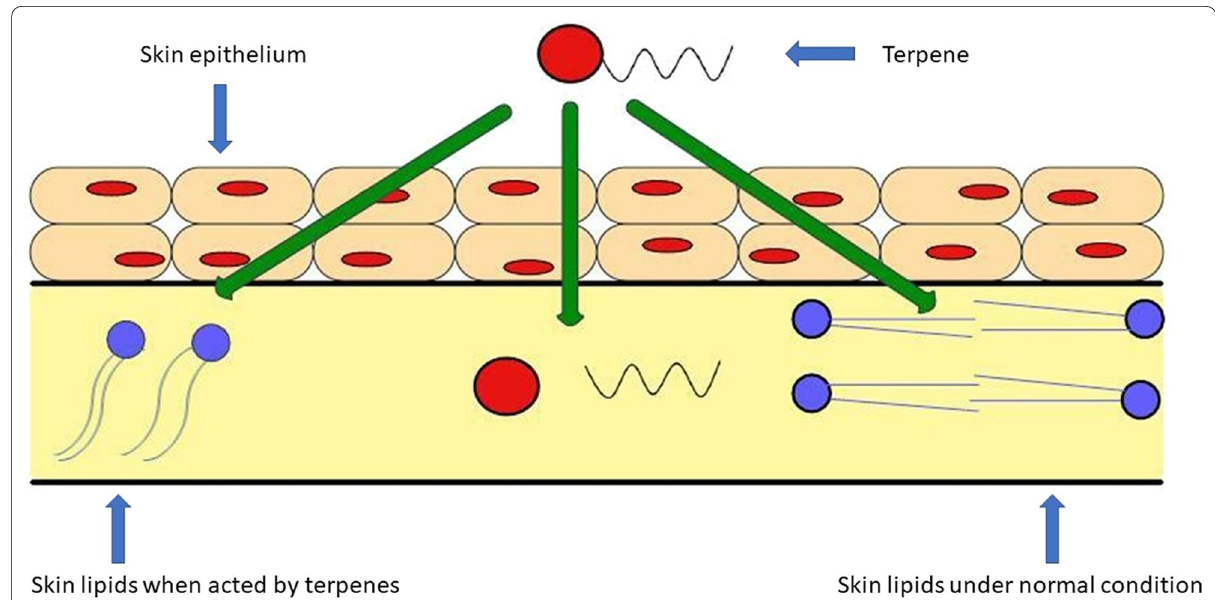
Fig. 1 Terpenes mechanism of action as a permeation